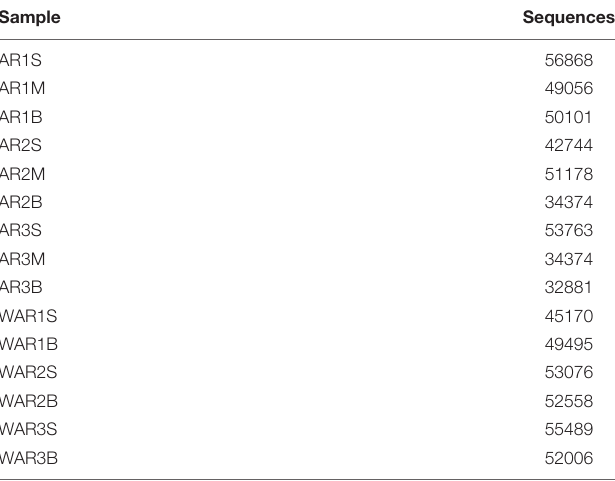
TABLE 1 | Statistics for the sequencing volume.